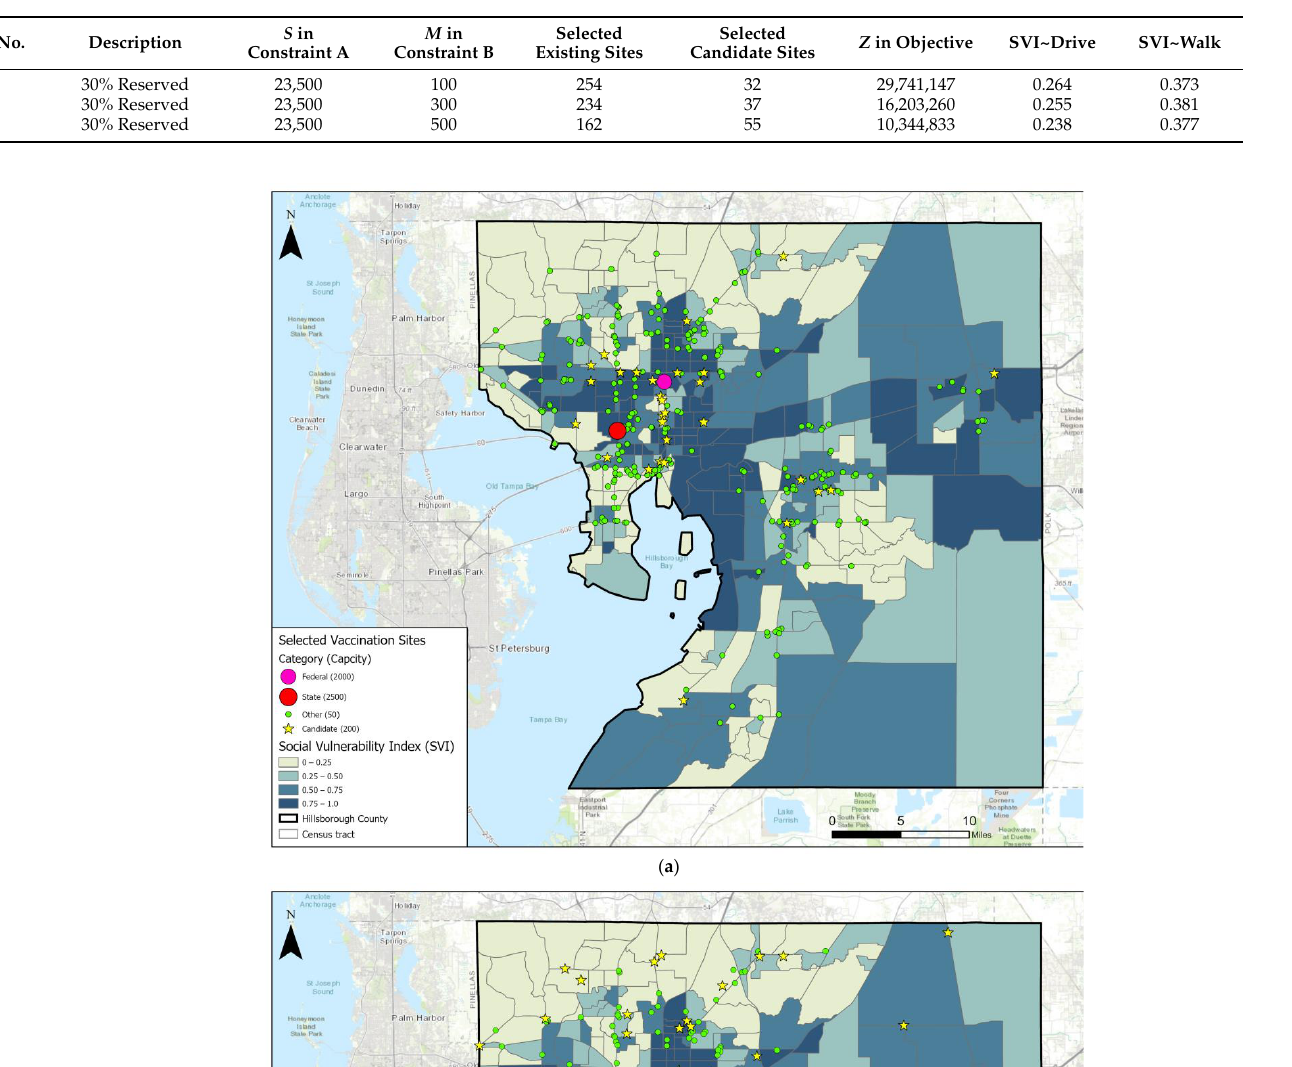
Table 2. Model results with different M values in constraint B.